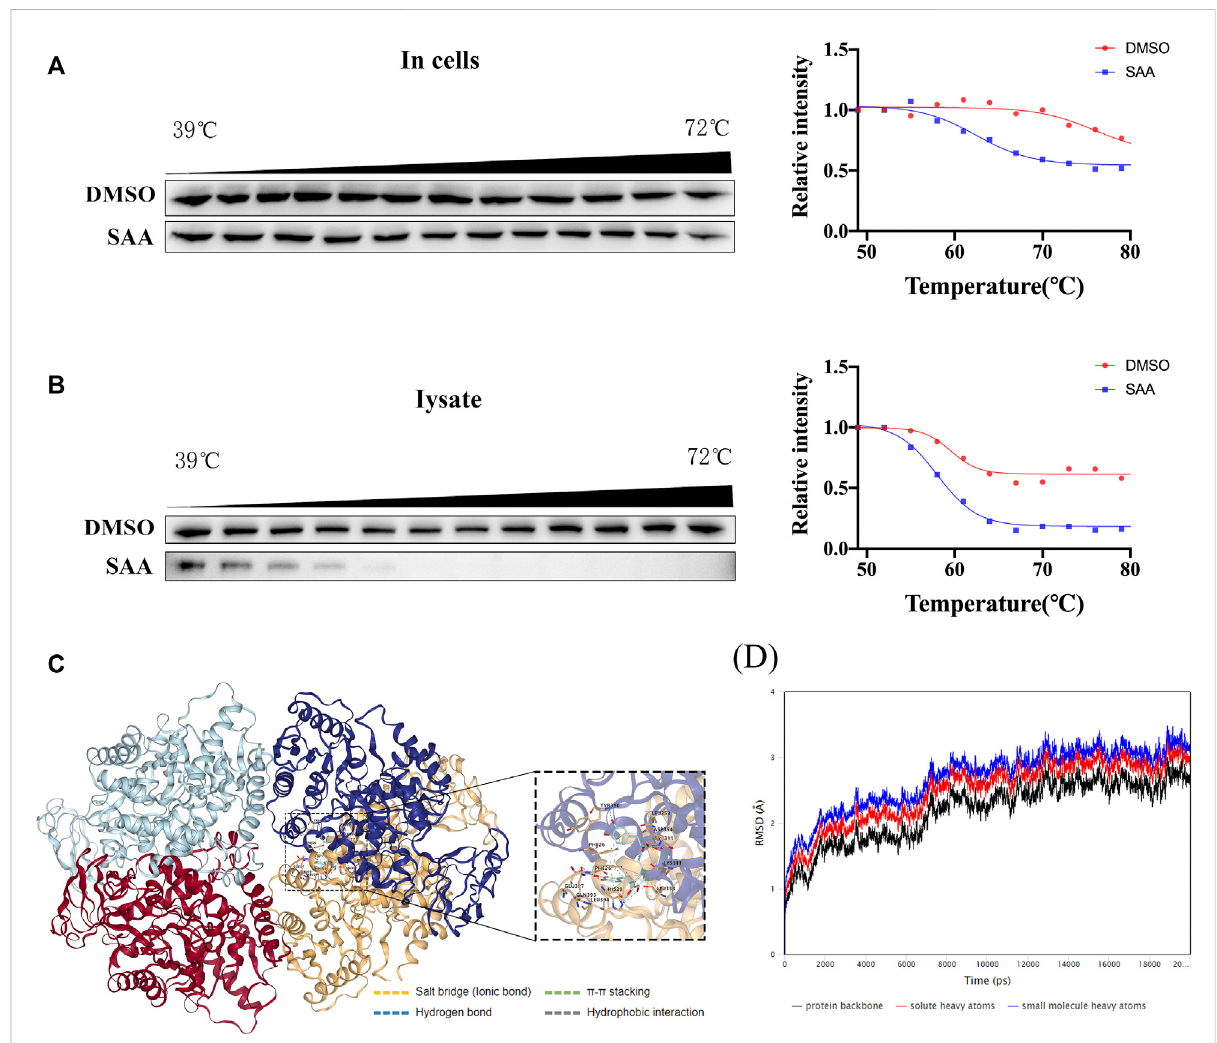
SAA binds to PKM2 in HUVECs. (A – B) Cells were incubated with DMSO or SAA for 6 h, and CETSA analyzed the thermal stabilization of PKM2 protein at different temperatures and concentrations ( n = 3). (C) Binding pose of SAA and PKM2 as shown by molecular docking